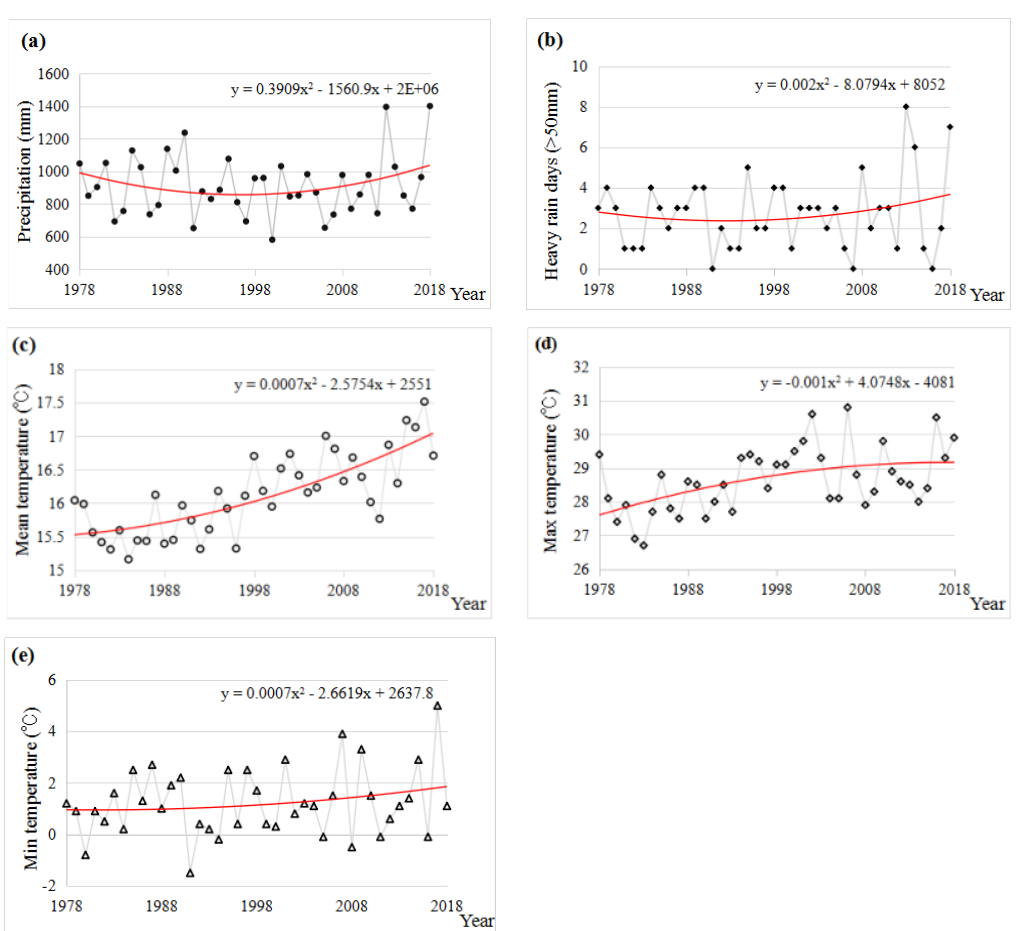
Figure 4. Annual precipitation ( a ), heavy rain days ( b ), mean temperature ( c ), max temperature ( d ) and min. temperature ( e ) during 1978 – 2018 in the Chengdu Plain.